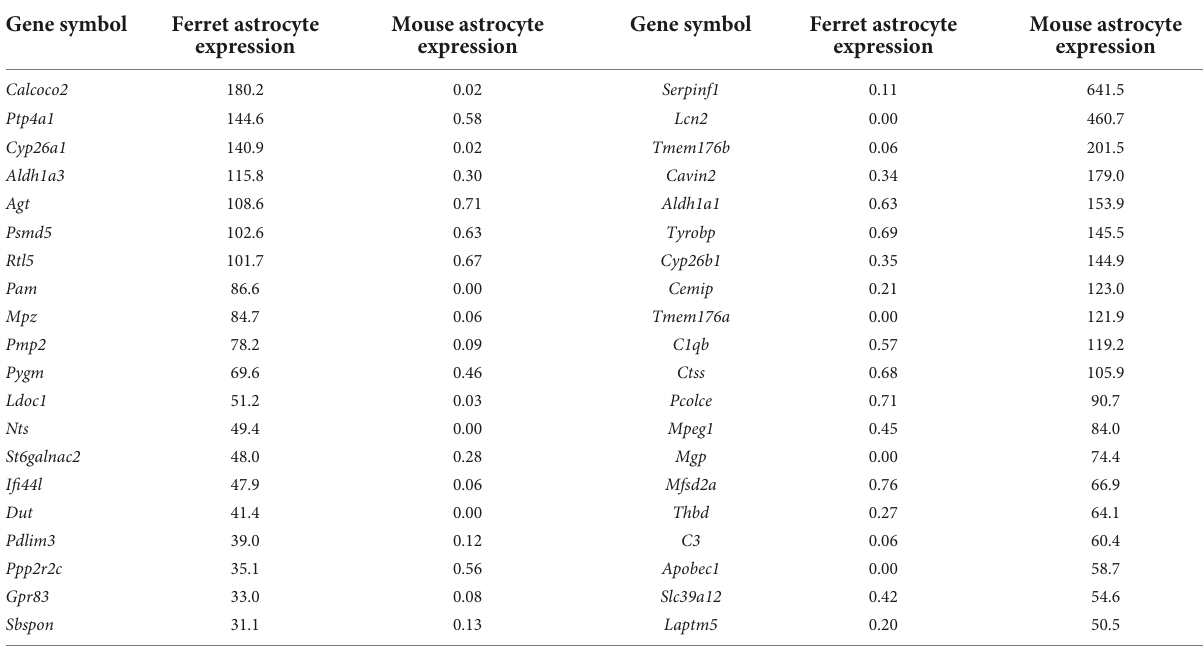
TABLE 1 Expression of top 20 species-specific genes. Genes in ferret astrocytes not found in mouse astrocytes Genes in mouse astrocytes not found in ferret astrocytes Gene symbol Ferret astrocyte Mouse astrocyte Gene symbol Ferret astrocyte Mouse astrocyte expression expression expression expression Calcoco2